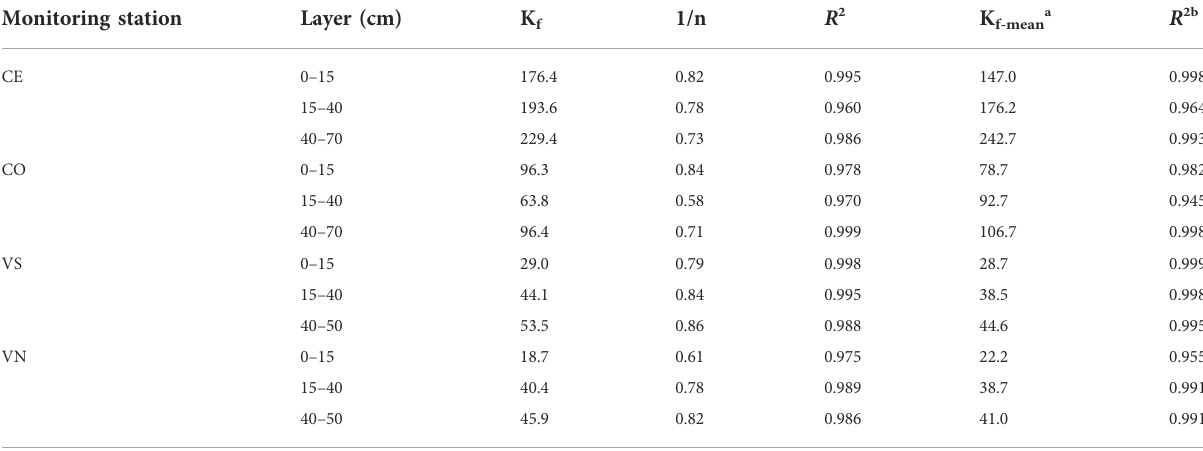
TABLE 6 Freundlich equation parameters for GLP (K f , n, and K f-mean ) and coef fi cients of determination ( R 2 ) for different monitoring stations and soil layers. K f and K f-mean are reported in μ g 1 – 1/n (ml) 1/n g − 1 . Monitoring station